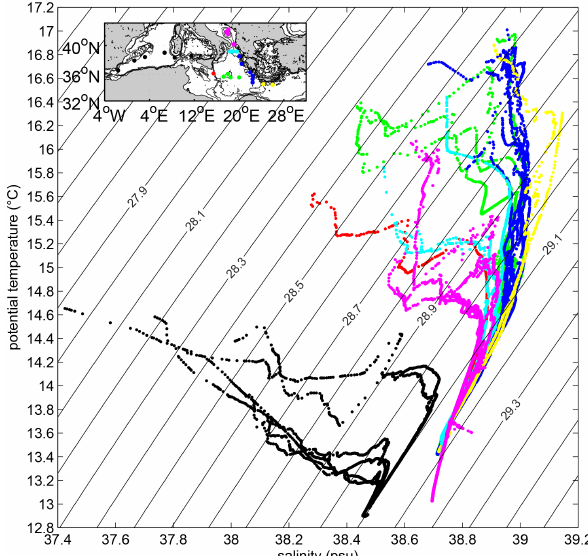
Figure 3. TS diagram determined by CTD data. The inner panel shows the location of CTD stations. The colours correspond to the colours of the profiles.